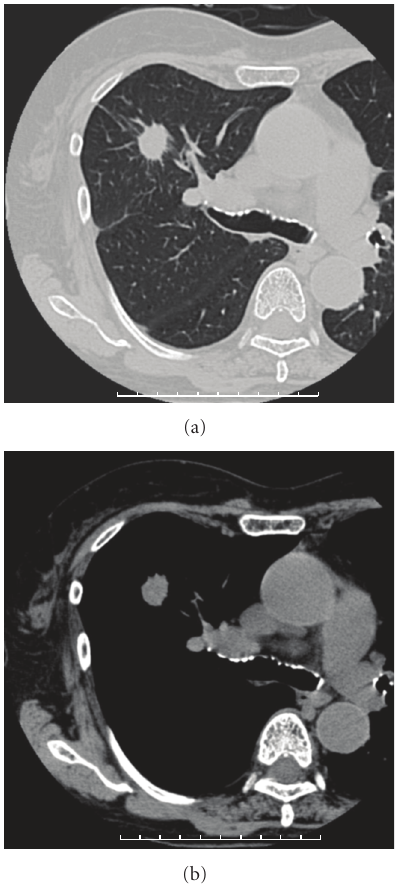
Figure 1: CT images before SBRT showing a solitary lung tumor in the right upper lobe.